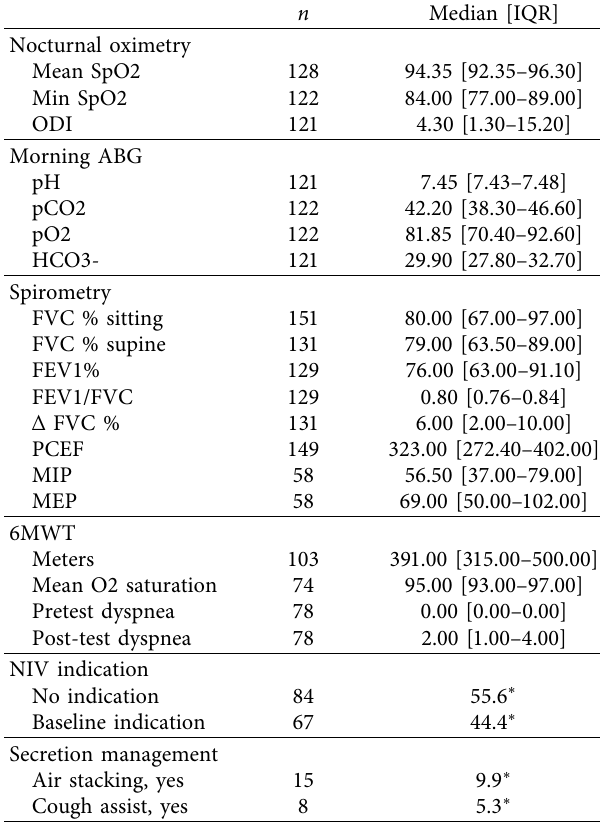
Table 1: Demographic and clinical features of the whole cohort ( n � 151).